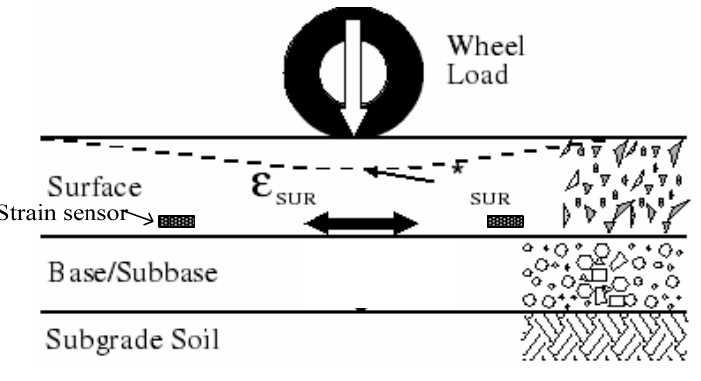
Figure 3. Illustration of the strain caused by moving wheel loads.